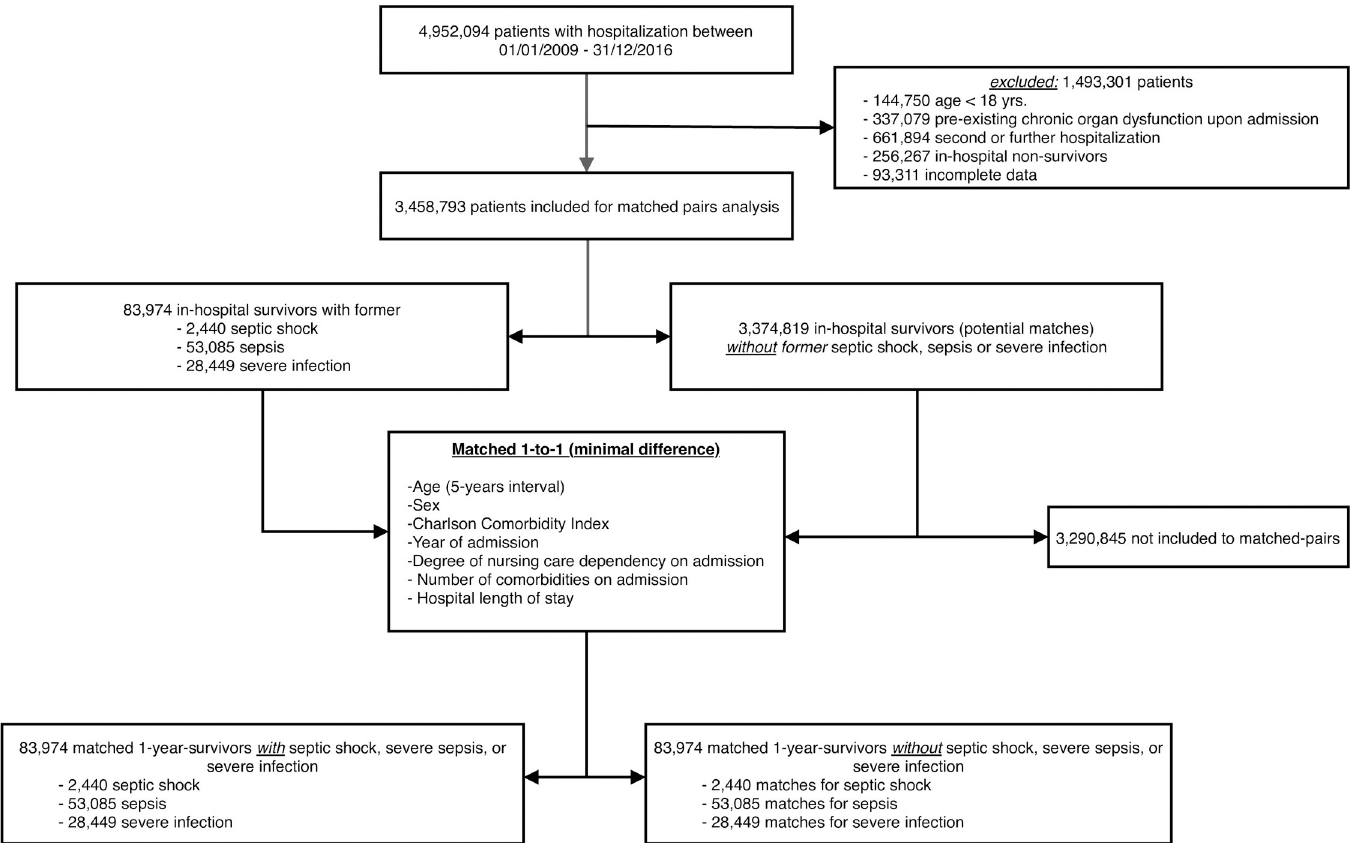
Fig 2. Flow chart showing selection of patients for matched analyses, shown for in-hospital survivors and non-survivors.